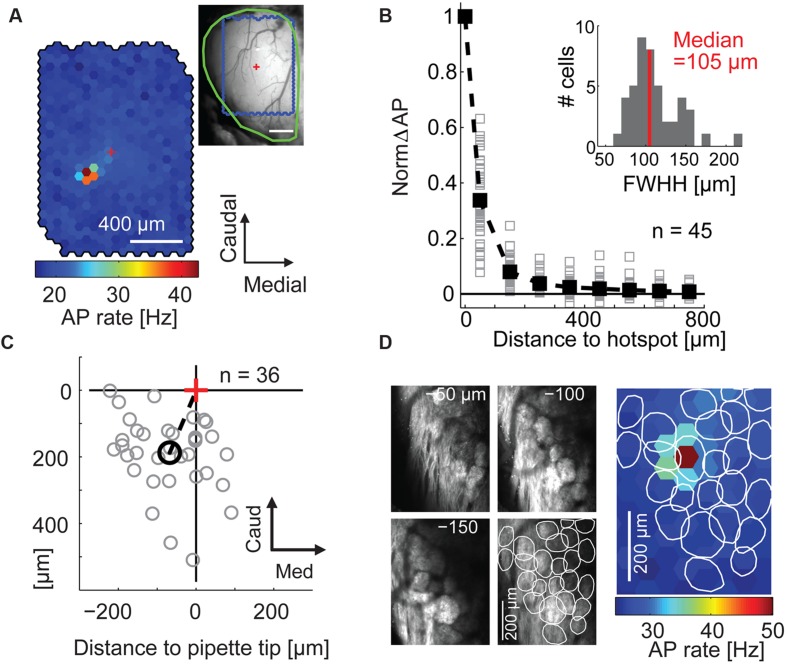
Maps of stimulation efficacy reveal hotspots that correspond to glomeruli. (A) Color-coded map of stimulation efficacy: for every stimulated spot the map displays the average AP rate during all frames the spot was flashed; 1,500 flashes per spot. Top right, blood vessel pattern of the dorsal OB with the outline of the stimulated area (blue), the electrode position (red cross), and the outline of the exposed OB (green). (B) Stimulation efficacy as a function of distance from the hotspot (100 μm bins, n = 45 MTCs, solid squares, average). Inset, hotspot width obtained by fitting Gaussians to the activation maps of the individual experiments. FWHH, full width at half height. (C) Position of the hotspots (gray circles) relative to tip of recording electrode (red cross) for all 36 MTCs with known pipette tip position. Black circle, mean hotspot position. (D) Overlay of the color-coded stimulation efficacy and the outlines of glomeruli identified by 2-photon microscopy in the same animal.